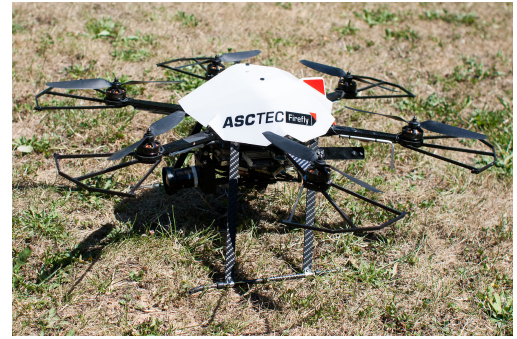
Figure 12. AscTec Firefly with the mounted uEye